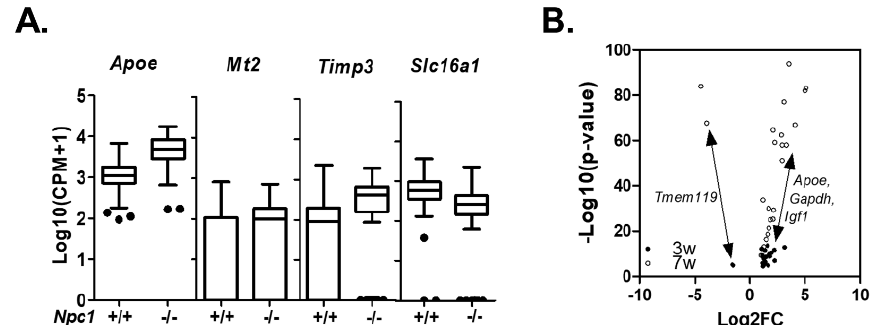
Figure 7. Differentially expressed genes at three weeks of age. ( A ) Tukey Box plot of genes showing differential expression Npc1+/+ and Npc1 −/− endothelial cells. ( B ) Volcano plot of significantly differentially expressed genes in microglia from Npc1 +/+ and Npc1 −/− . X axis Log2 fold change between Npc1 −/− and Npc1 +/+ microglia. Y axis is the -Log10 p -value. Black dots and clear circles indicate data from three- and seven-week-old mice, respectively.